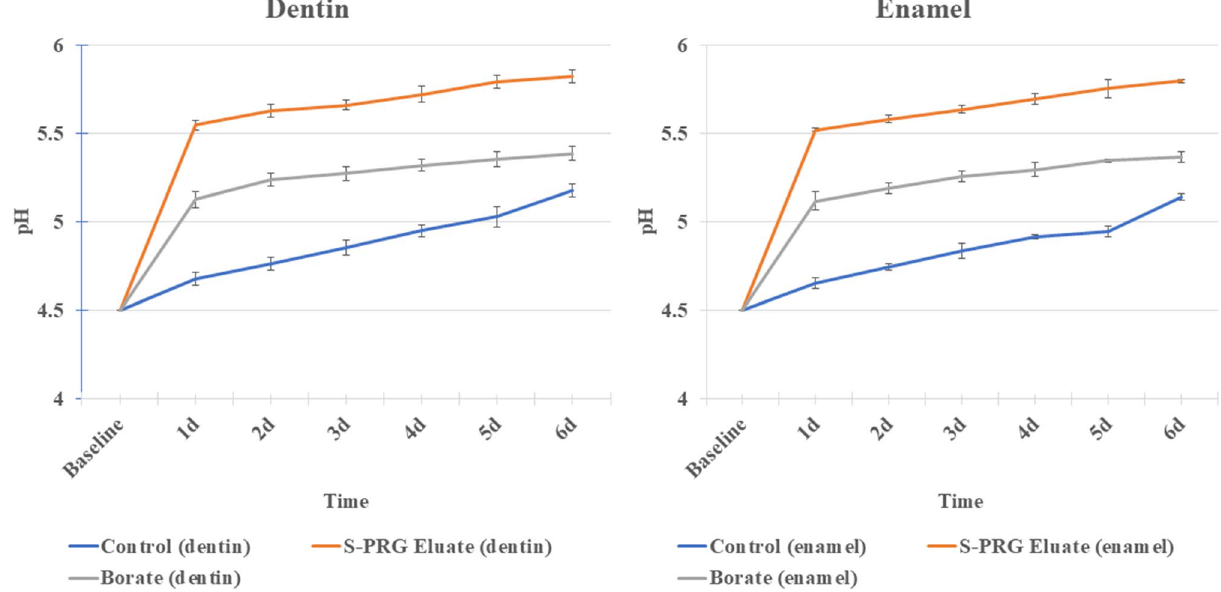
Figure 3. The pH plotted against time showing the changes in the pH values for the different tested groups. Statistical analysis was performed using two-way repeated measures